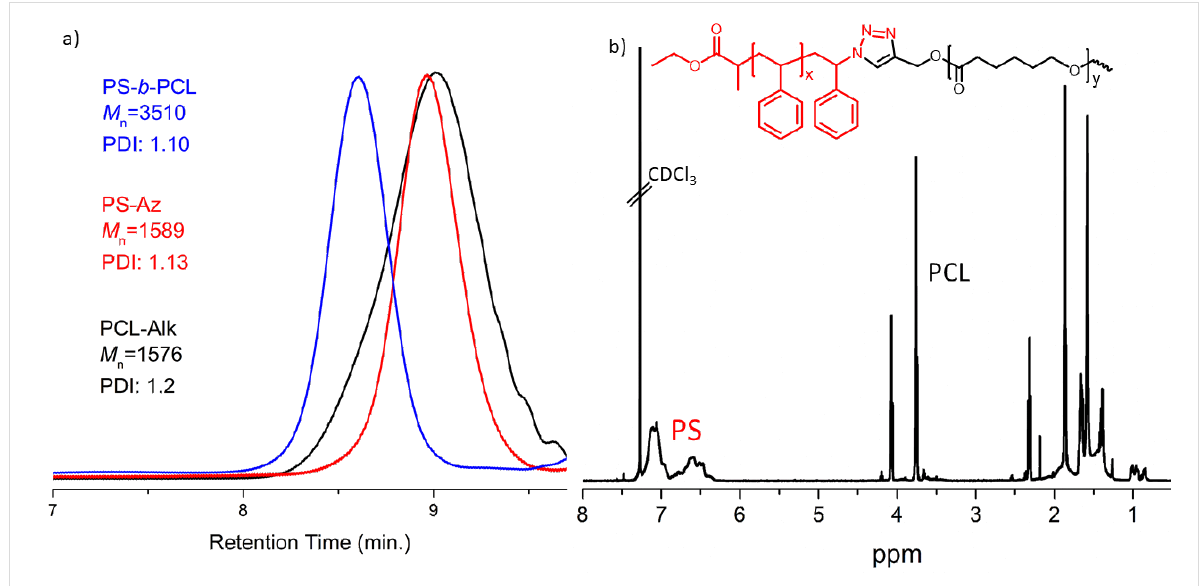
Figure 5: a) GPC traces of PS-Az , PCL-Alk and block copolymer ( Ps- b -PCL ) b) 1 H NMR spectrum of the block copolymer ( Ps- b -PCL ).